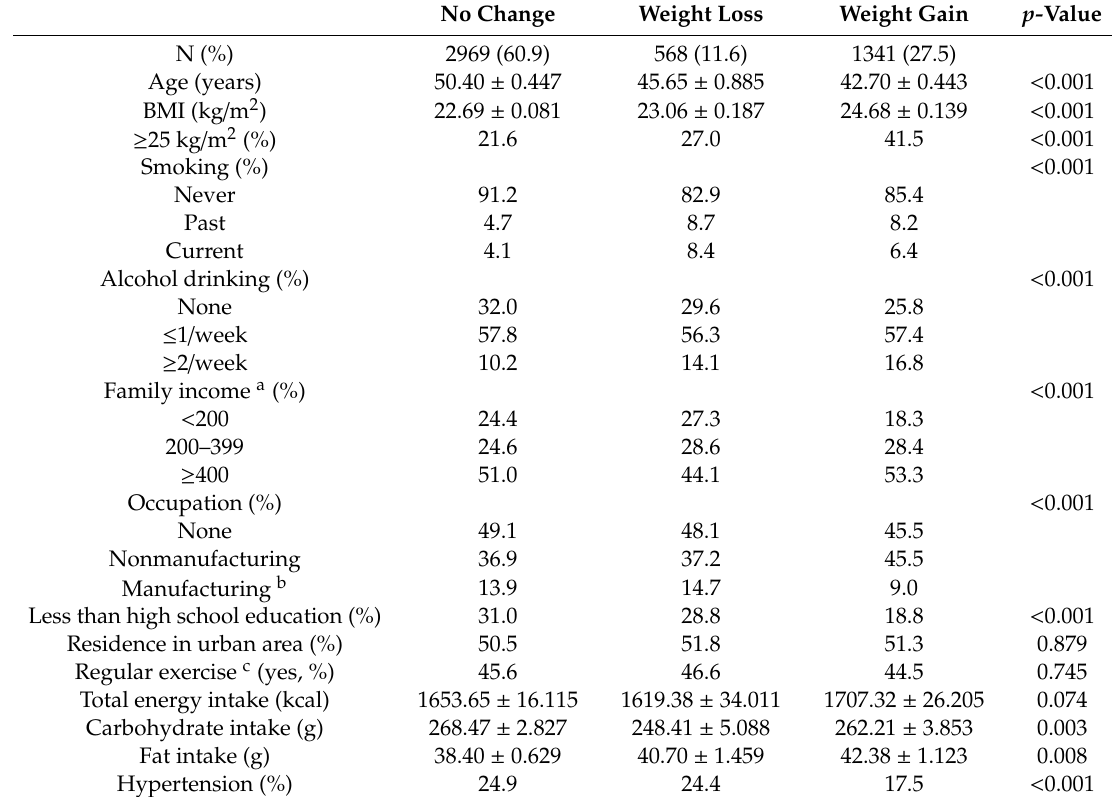
Table 2. Characteristics of the study population in